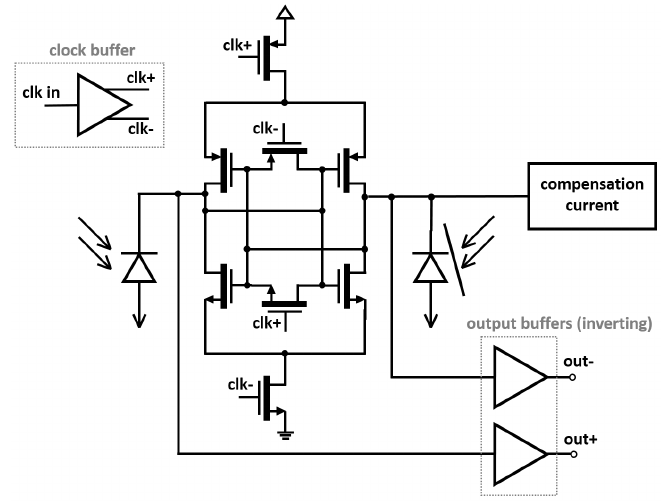
Figure 2. Circuit diagram of the opto-electronic integrated circuit (OEIC). The two clock phases (clk+ and clk − ) successively activate and deactivate the latch.